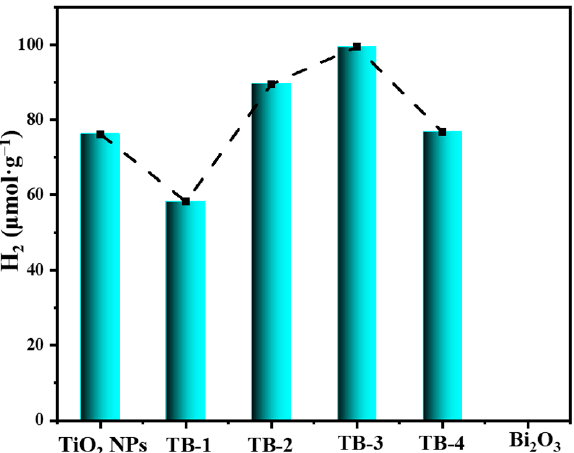
Figure 10. Photocatalytic hydrogen production of TiO 2 NPs, Bi 2 O 3 , and TB-x (x = 1–4).